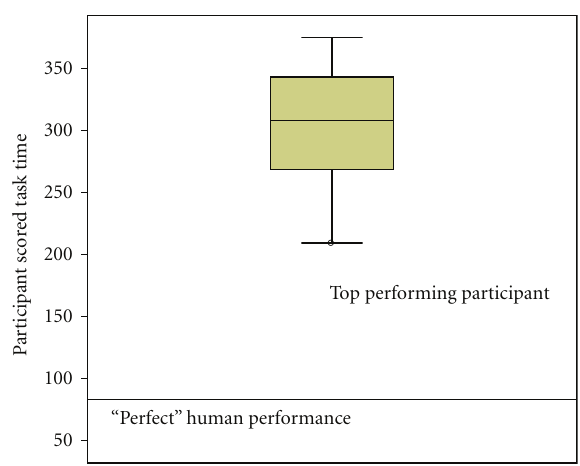
Figure 10: Box plot of participants’ times to complete the scored